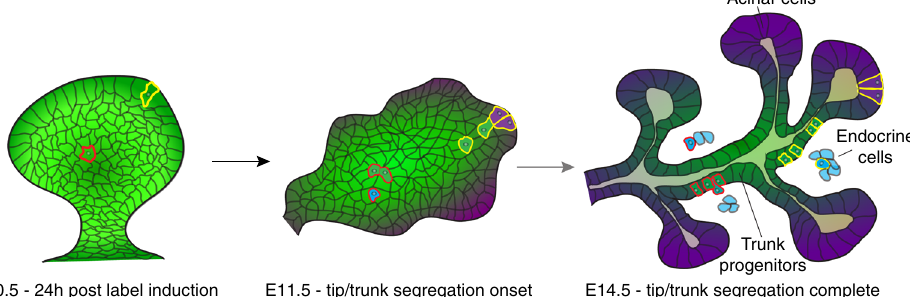
Fig. 8 Proposed model of orchestration of pancreas organogenesis by heterogeneous clones. Although initially possessing the same intrinsic potency, the spatial position of induced clones in the pancreatic bud in fl uences expressed in vivo potency by dispersing clonal progeny to different niches. While peripherally labelled cells ( yellow outline ) will be exposed to acinar-inducing cues concomitant with generation of trunk-fated progeny during branching morphogenesis, centrally labelled cells ( red outline ) are less likely to experience acinar-inducing signals and thus produce ducto-endocrine bipotent clones. Stochastic priming of centrally located progenitors towards the endocrine lineage might further generate heterogeneity in clonal contribution to the